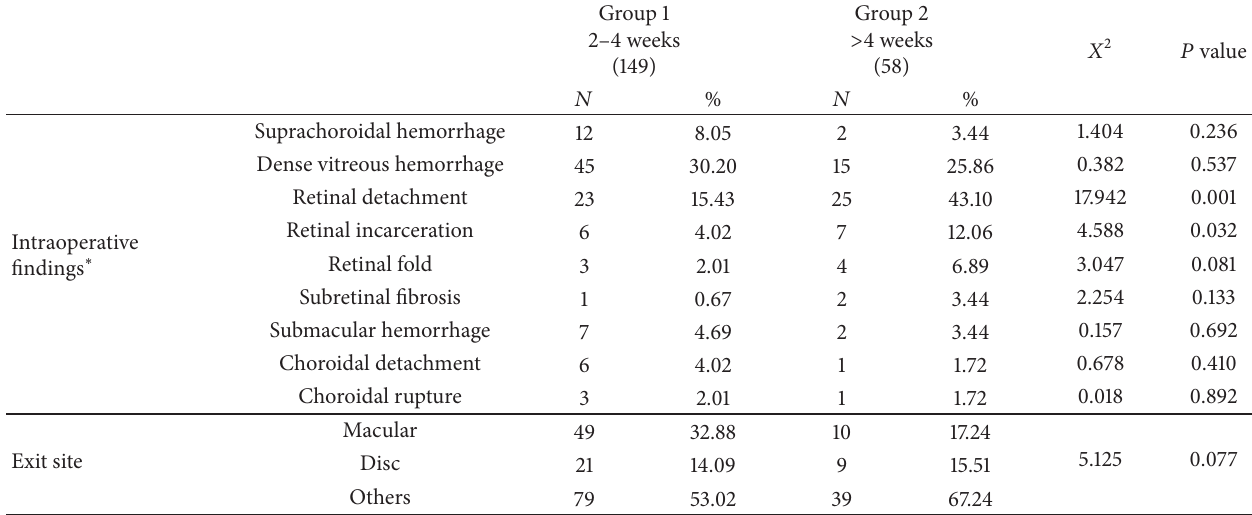
Table 2: Intraoperative findings and exit site of the studied